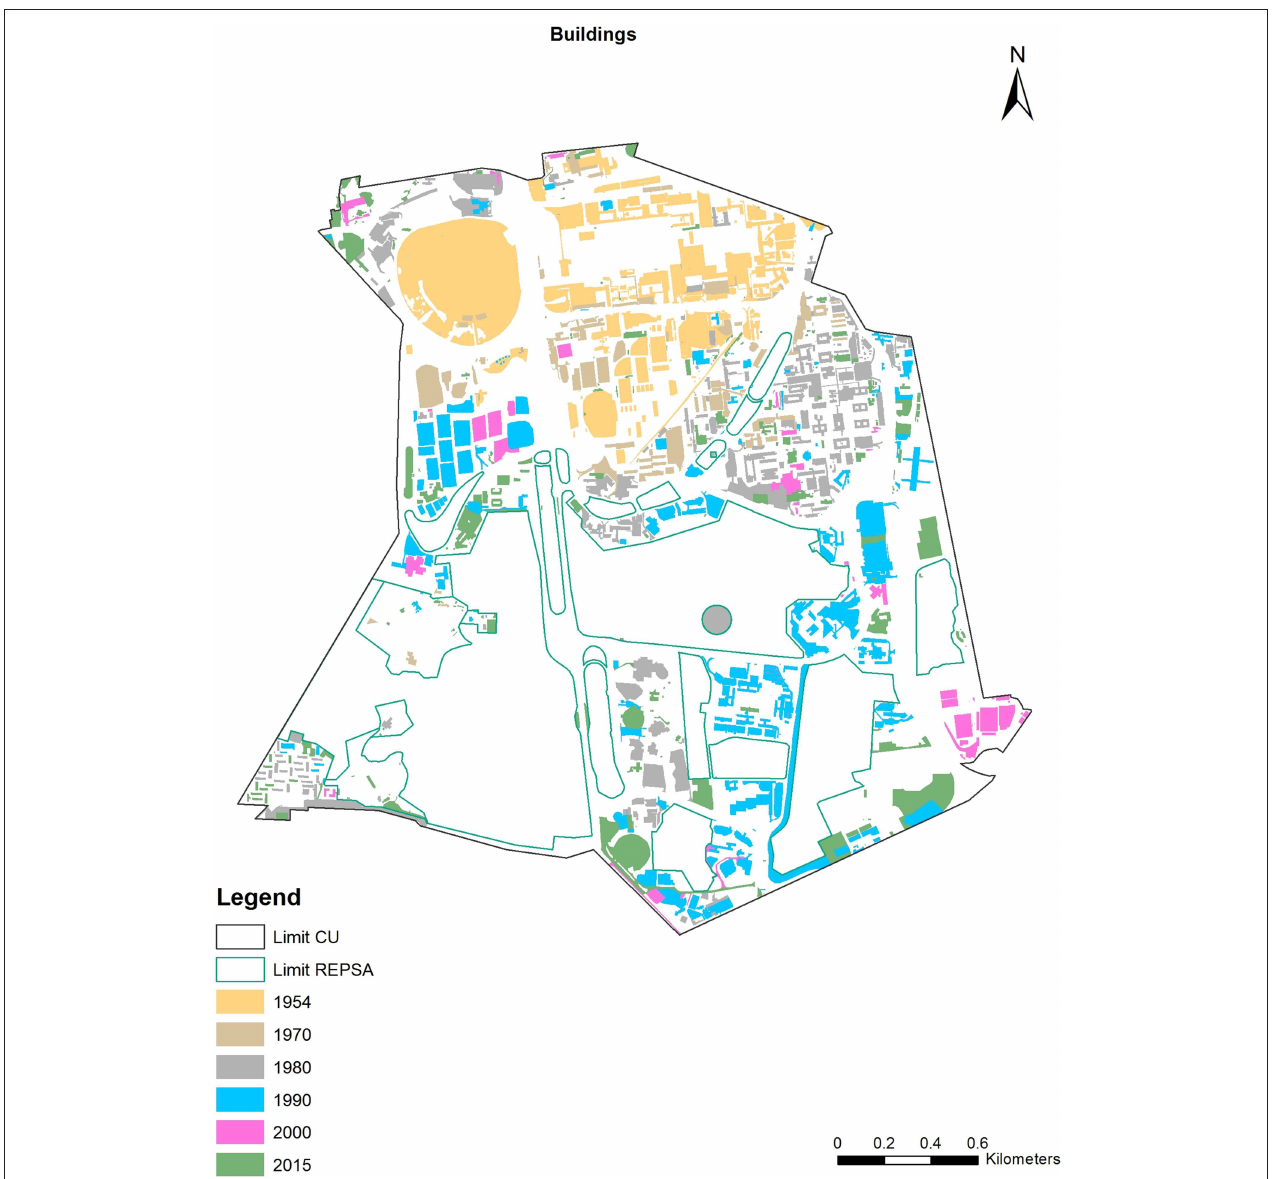
FIGURE 1 | Map of the campus with the new construction from its establishment in 1954–2015.